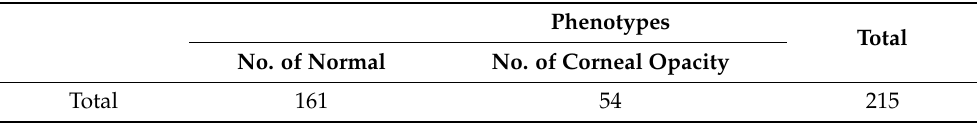
Table 2. Occurrence of corneal opacity in PG1 transgenic